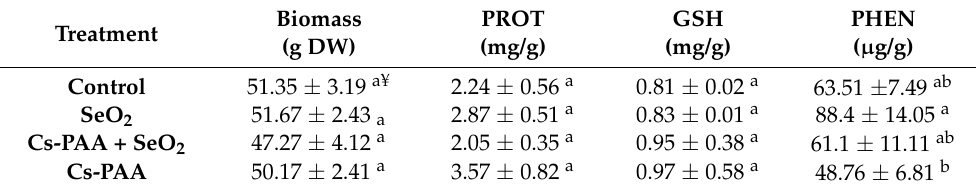
Table 1. Comparison of means of biomass and biochemical variables.